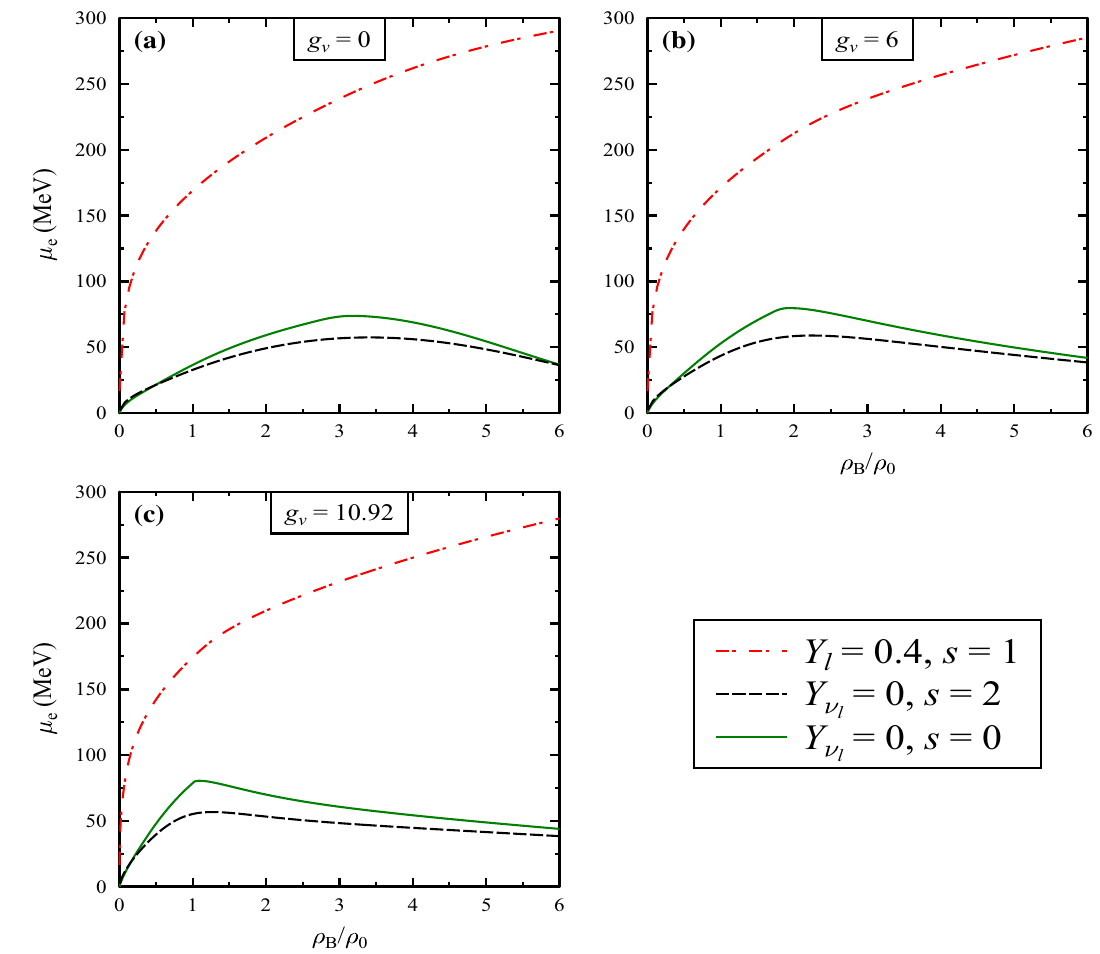
Fig. 5 The electron chemical potential as a function of baryonic density, ρ B (in units of nuclear saturation density ρ 0 ) for three snapshots of PQS evolution at g v = 0, 6 and 10.92